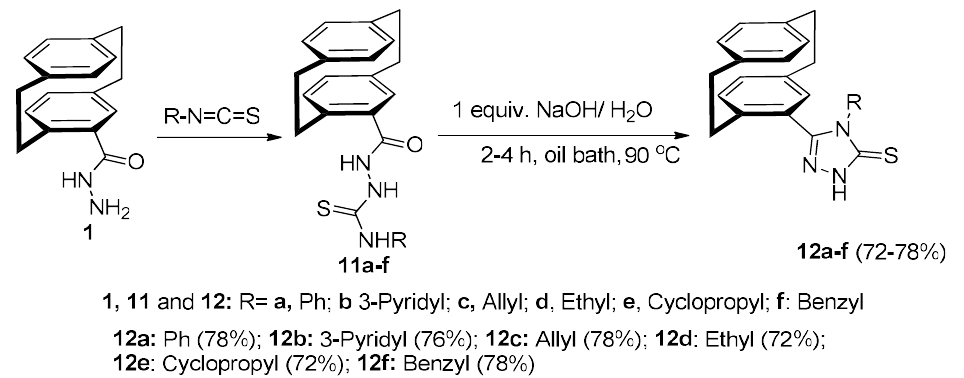
Scheme5. Preparationof4-substituted5-(1,4(1,4)-dibenzenacyclohexaphane-1 2 -yl)-2,4-dihydro-3 H -1,2,4- triazol-3-thiones 12a – f .